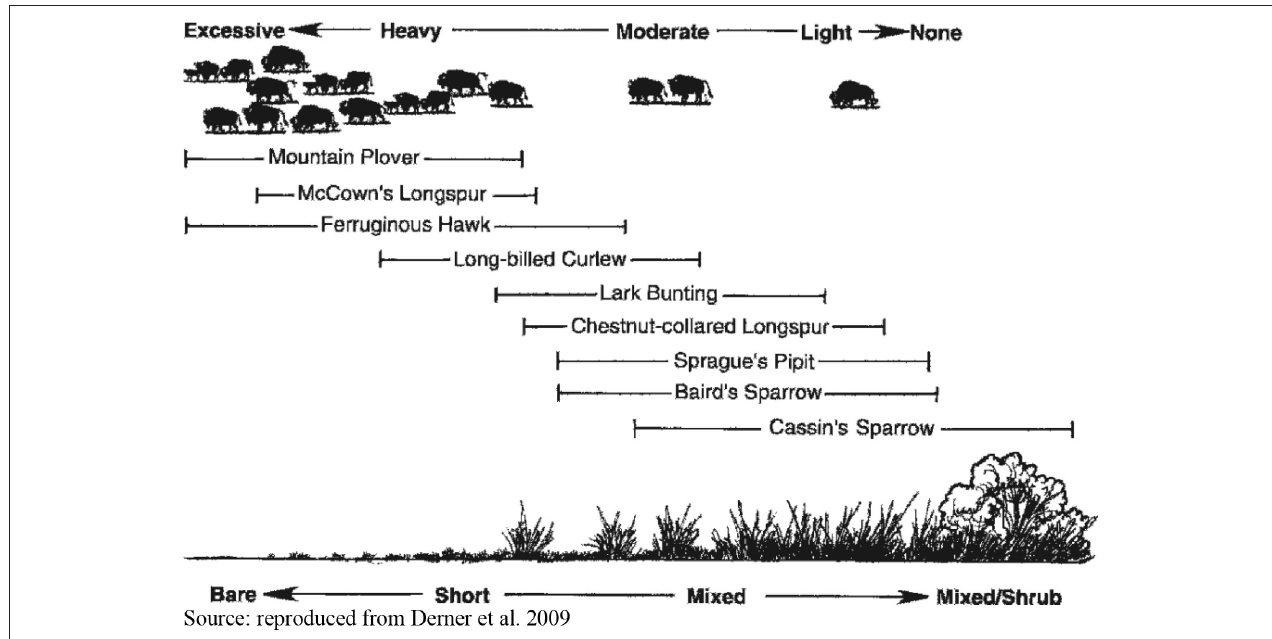
FIGURE 1 | Responses of grassland birds in shortgrass steppe to a vegetation structure gradient. Source: reproduced from Derner et al.